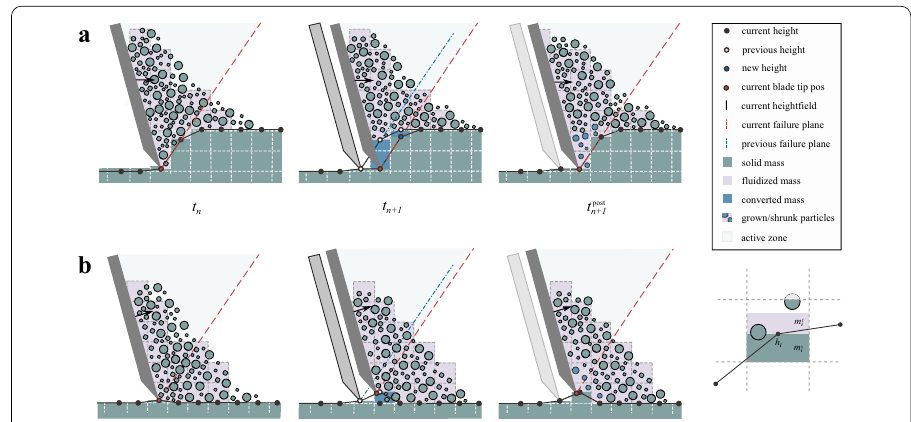
Fig. 3 As a blade and its active zone moves into the terrain a , new solid voxels are resolved into particles or fluidized mass that form the aggregate body. The voxel height value, corresponding to the solid occupancy, is found by projection to the failure plane of the active zone. When the blade is raised b , the gap is filled by solid mass converted from fluidized or particle mass in the vicinity of the edge